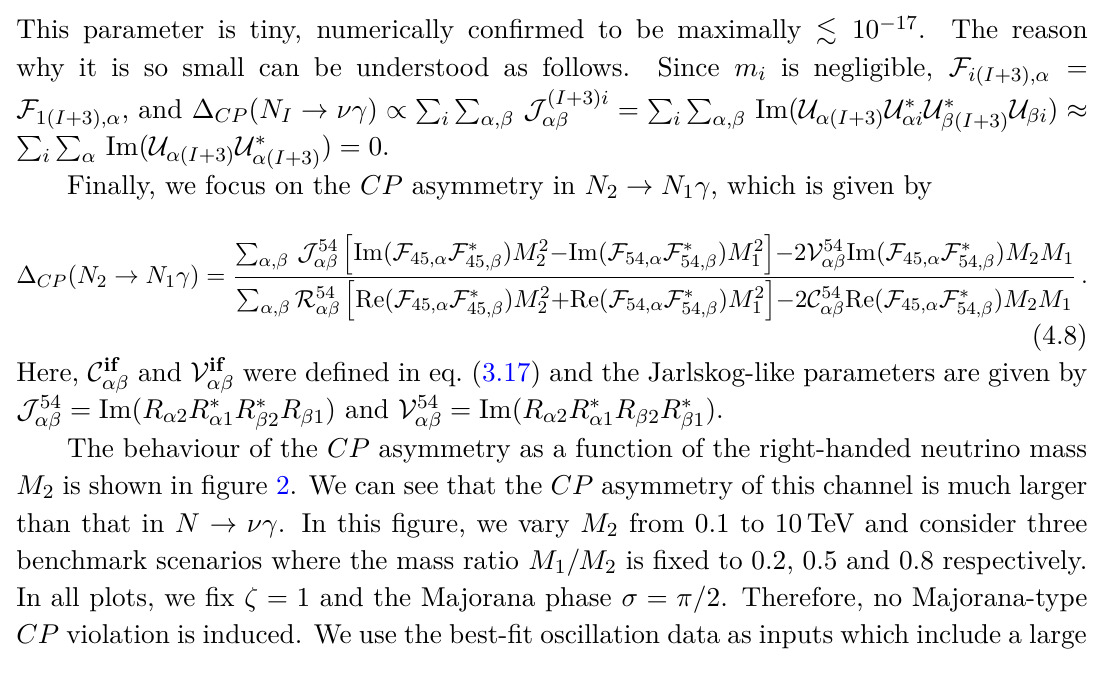
Figure 2 . The CP asymmetry (left panel) and branching ratio (right panel) for the radiative decay process N 2 → N 1 γ as a function of the heavy neutrino mass M 2 . Four different benchmarks for the lightest right-handed neutrino M 1 = 0 . 2 M 2 , 0 . 5 M 2 , 0 . 8 M 2 are considered as per the respective plot legends. Values of ω are fixed at ω = 5 (top panel) and 5 − 5 i (bottom panel), respectively. In all cases, we use the best-fit oscillation data as inputs while we set ζ = 1 with a Majorana phase σ = π/ 2